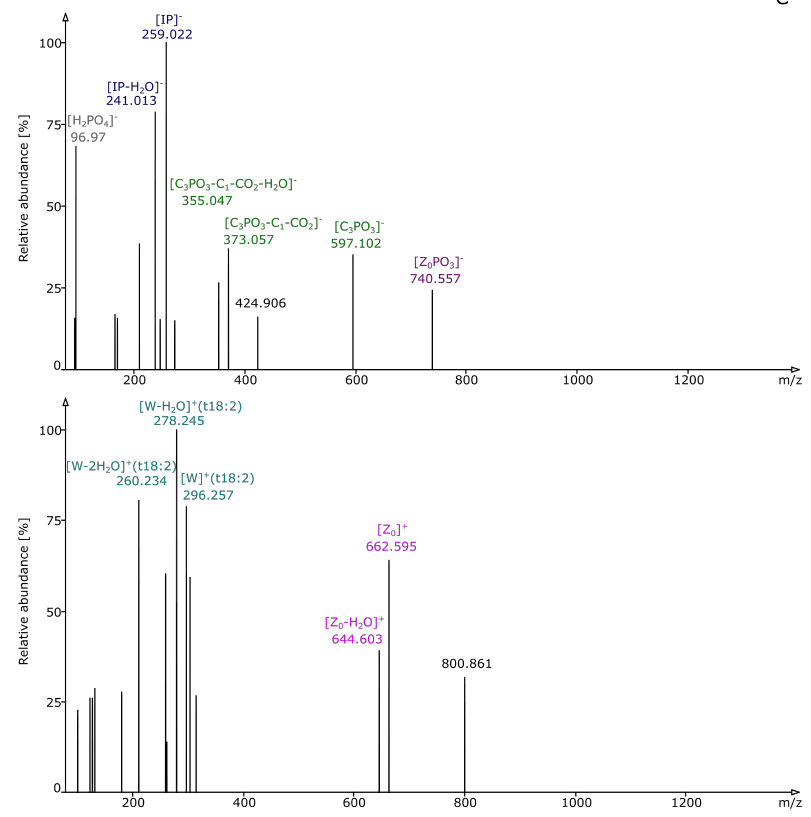
Figure A3. ( A ) Extracted ion chromatograms of GIPCs in positive ion mode, having a t18:2 LCB annotation on levels 2 and 3 in raspberries (A-NAc-t18:2 / h24:0, A-NH 2 -t18:2 h22:0 and h24:0, as well as A-OH-t18:2 / h24:0). The ddMS2 spectra of GIPCs A-NH 2 -t18:2 / h24:0 at the retenion time of 16.1 min ( B ) A-OH-t18:2 / h24:0 at the retention time of 15.2 min and ( C ) in negative and positive mode, showing characteristic fragments. Table A2. The description of the plant samples, including plant species, origin, number of biological replicates, and the average fresh- and dry weights [g]. The extraction of GIPCs from strawberries and raspberries was performed one day after the collection was performed (28 June 2020). Plant Species Origin Replicates Fresh Weight [g] Dry Weight [g] Salad Local supermarket 4 ~1 ~0.04 Spinach Local supermarket